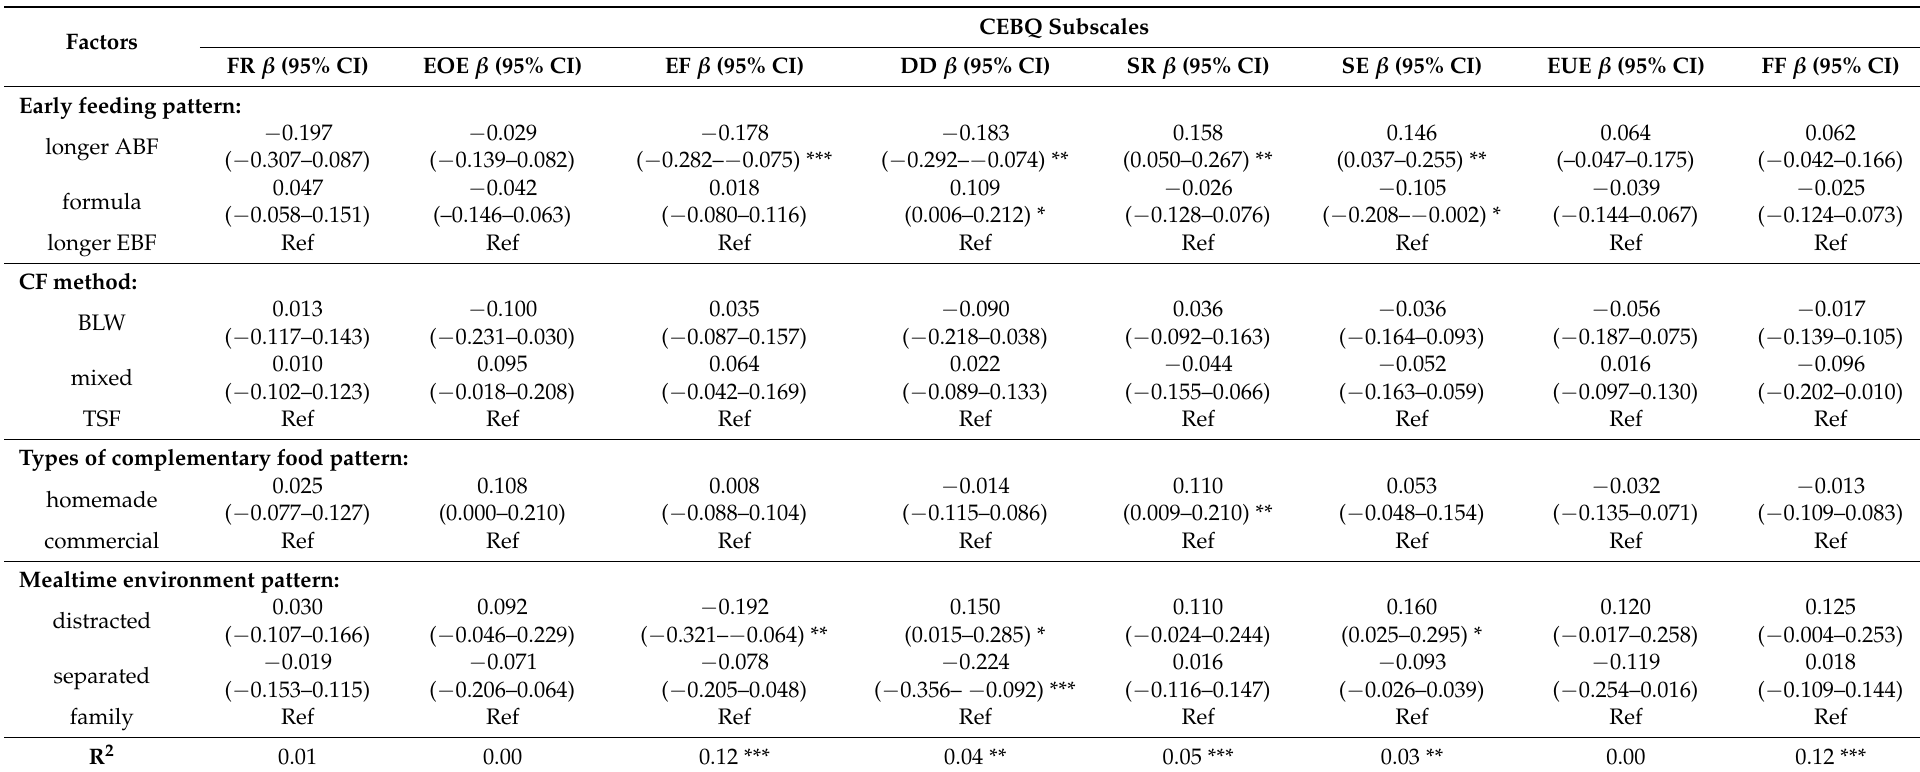
Table 4. Adjusted regression analysis predicting eating